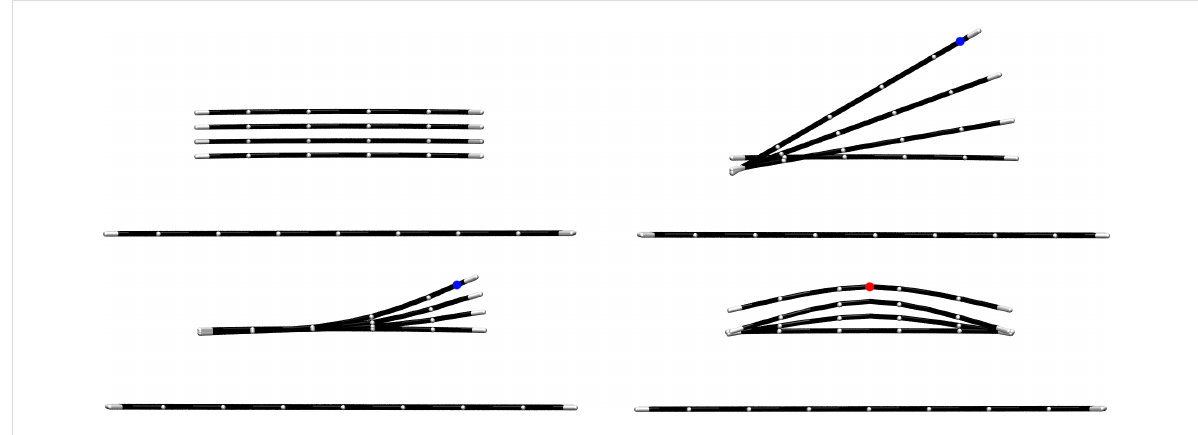
Figure 7: The separation of tetracene from graphene. Top row: Mode S1 (left), mode S2 (right). Bottom row: mode S3 (left), mode S4 (right). The blue and red dots indicate the pull-off points.